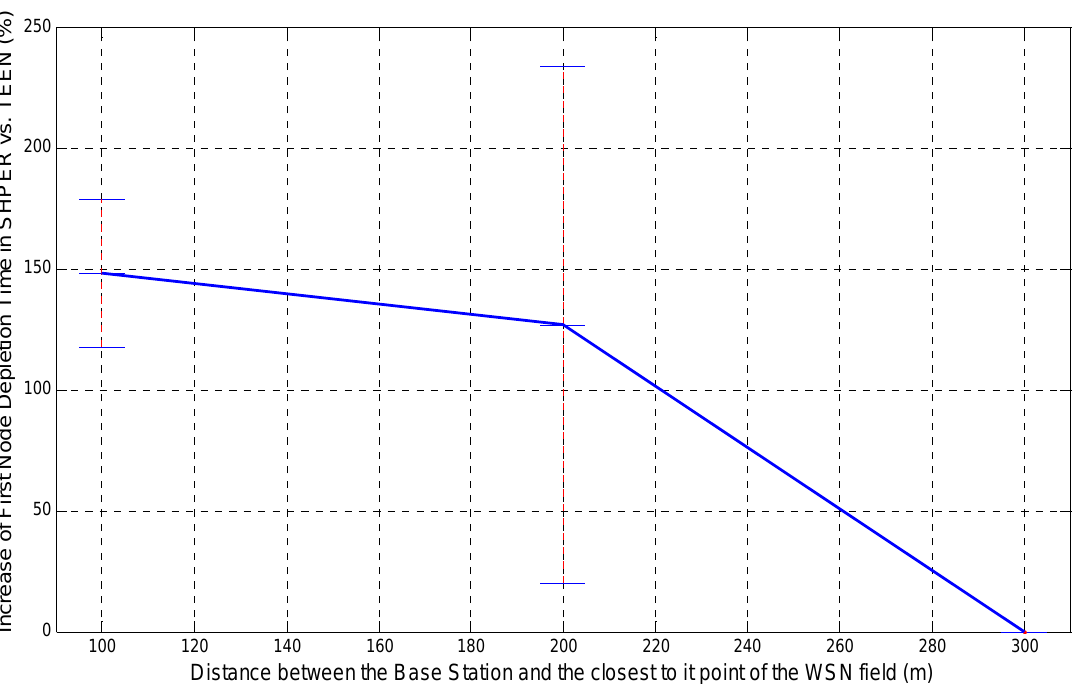
Figure 7. Percentage of the average increase of the time the first node depletes in SHPER opposed to TEEN over the distance of the base station from the WSN field, [ Er 0.5 J].